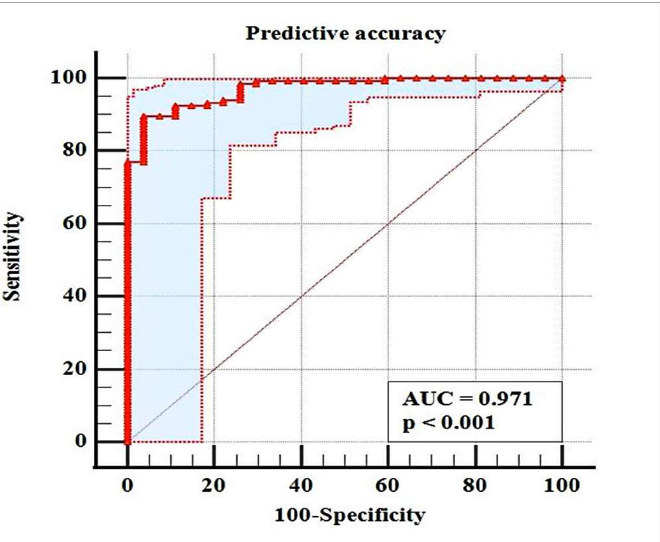
Figure 2. Accuracy of predicting residual stone with predictors stone size, density, burden, and location. The ROC curve is marked by the thick red curve. The lower and upper bounds of the 95% CI are indicated by thin red line curves on both sides of the ROC curve. The area of the 95% CI is colored in gray.